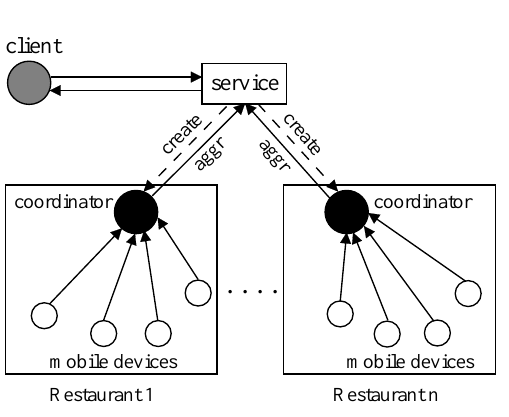
Figure 8. Restaurant Recommendation